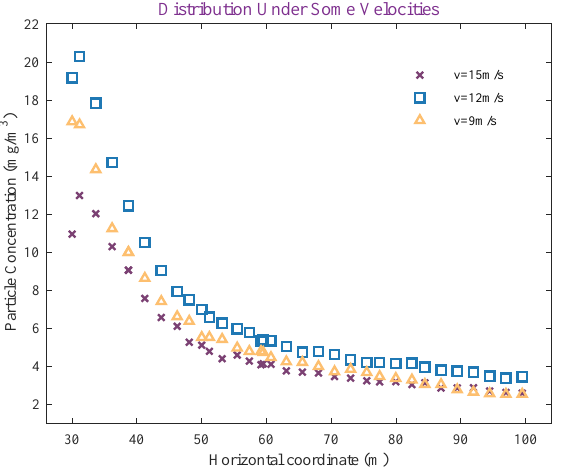
Figure 8. Variation of dust concentration with distance (9 m/s, 12 m/s, and 15